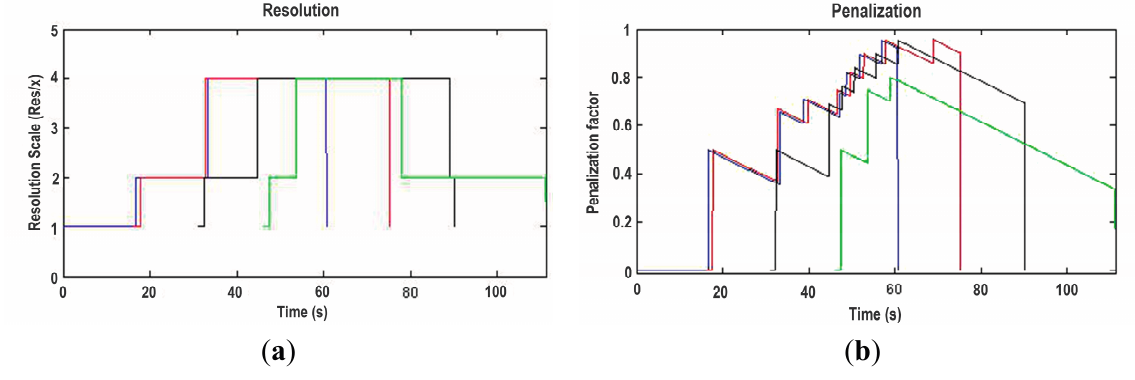
Figure 12. Evolution of the plugin image resolution ( a ); and the penalization factor ( b ).